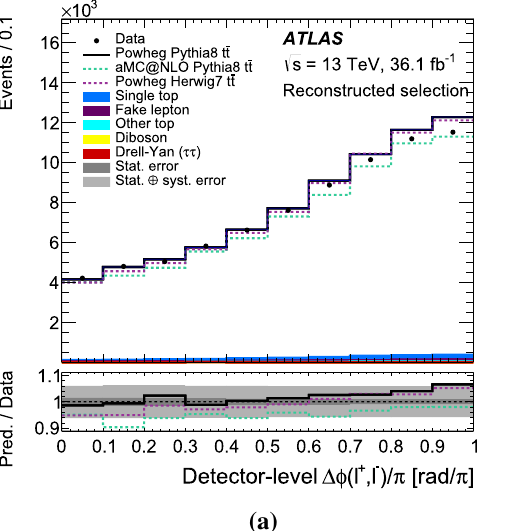
Fig. 2 Distribution of a the (cid:3)φ and b (cid:3)η observables for the e μ selection after the requirement of at least one b -tagged jet (inclusive selection). The highest bin for (cid:3)η also contains events that are above the x -axis range. The dark uncertainty bands in the ratio plots represent the statistical uncertainties while the light uncertainty bands represent the statistical and systematic uncertainties added in quadrature. The systematic uncertainties include contributions from leptons, jets, miss-